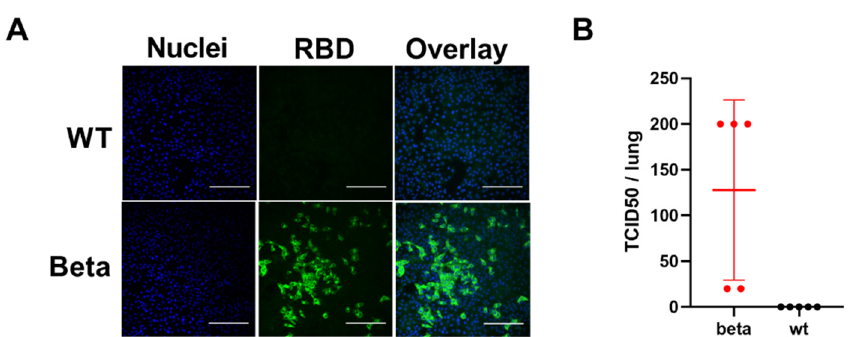
Figure 2. Viral titres in BALB/c mouse lungs after SARS-CoV-2 infection, determined in Vero E6 cells incubated for 2 days with lung homogenate of wt- or beta variant-infected BALB/c mice (2 and 3 dpi for beta and wt, respectively; n = 5 both). ( A ) Immunofluorescence image. Viral infection of cells was detected by a RBD-specific rabbit polyclonal Ab, followed by an AF488-conjugated secondary Ab (green). Nuclei were stained with Hoechst 33420 (blue). Bar = 100 µ m. ( B ) The TCID50 in lung tissues was calculated as assessed by immunofluorescence.